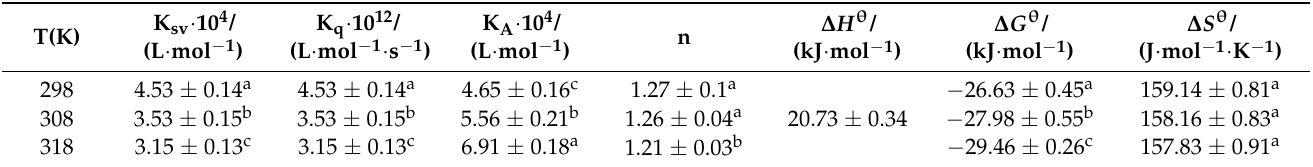
Figure 6. Stern–Volmer plots of SPA interaction with Mal-mPEG5000 at different temperatures. Table 2. Summary of the thermodynamic parameters for the interaction between Mal-mPEG5000 and SPA along with binding parameters K and n.